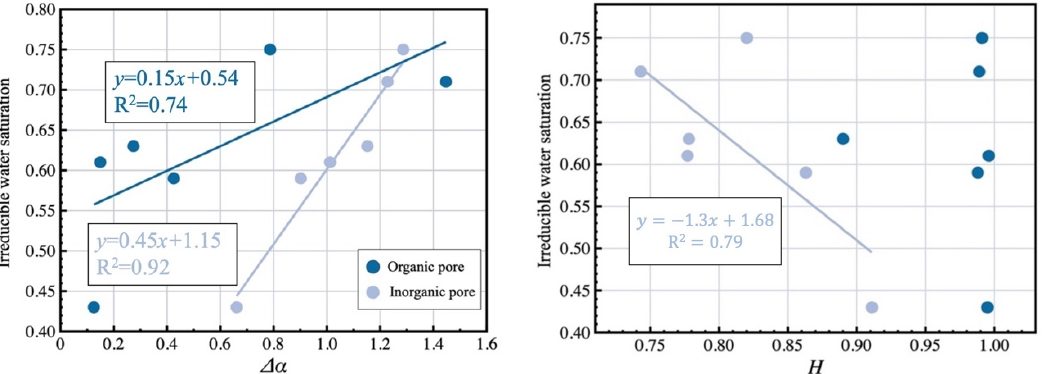
Figure 12. The relationships between multifractal characteristic parameters of organic and inorganic pores and irreducible water saturation.